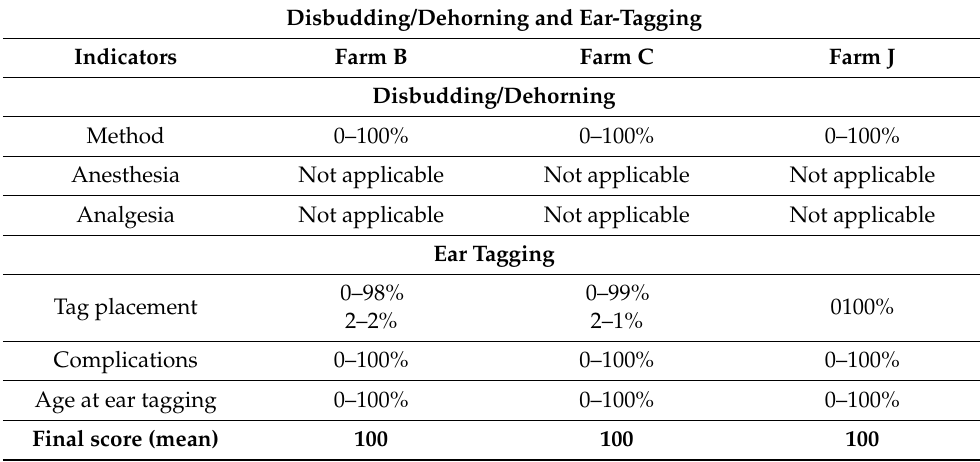
Table 6. Results regarding disbudding/dehorning and ear-tagging.